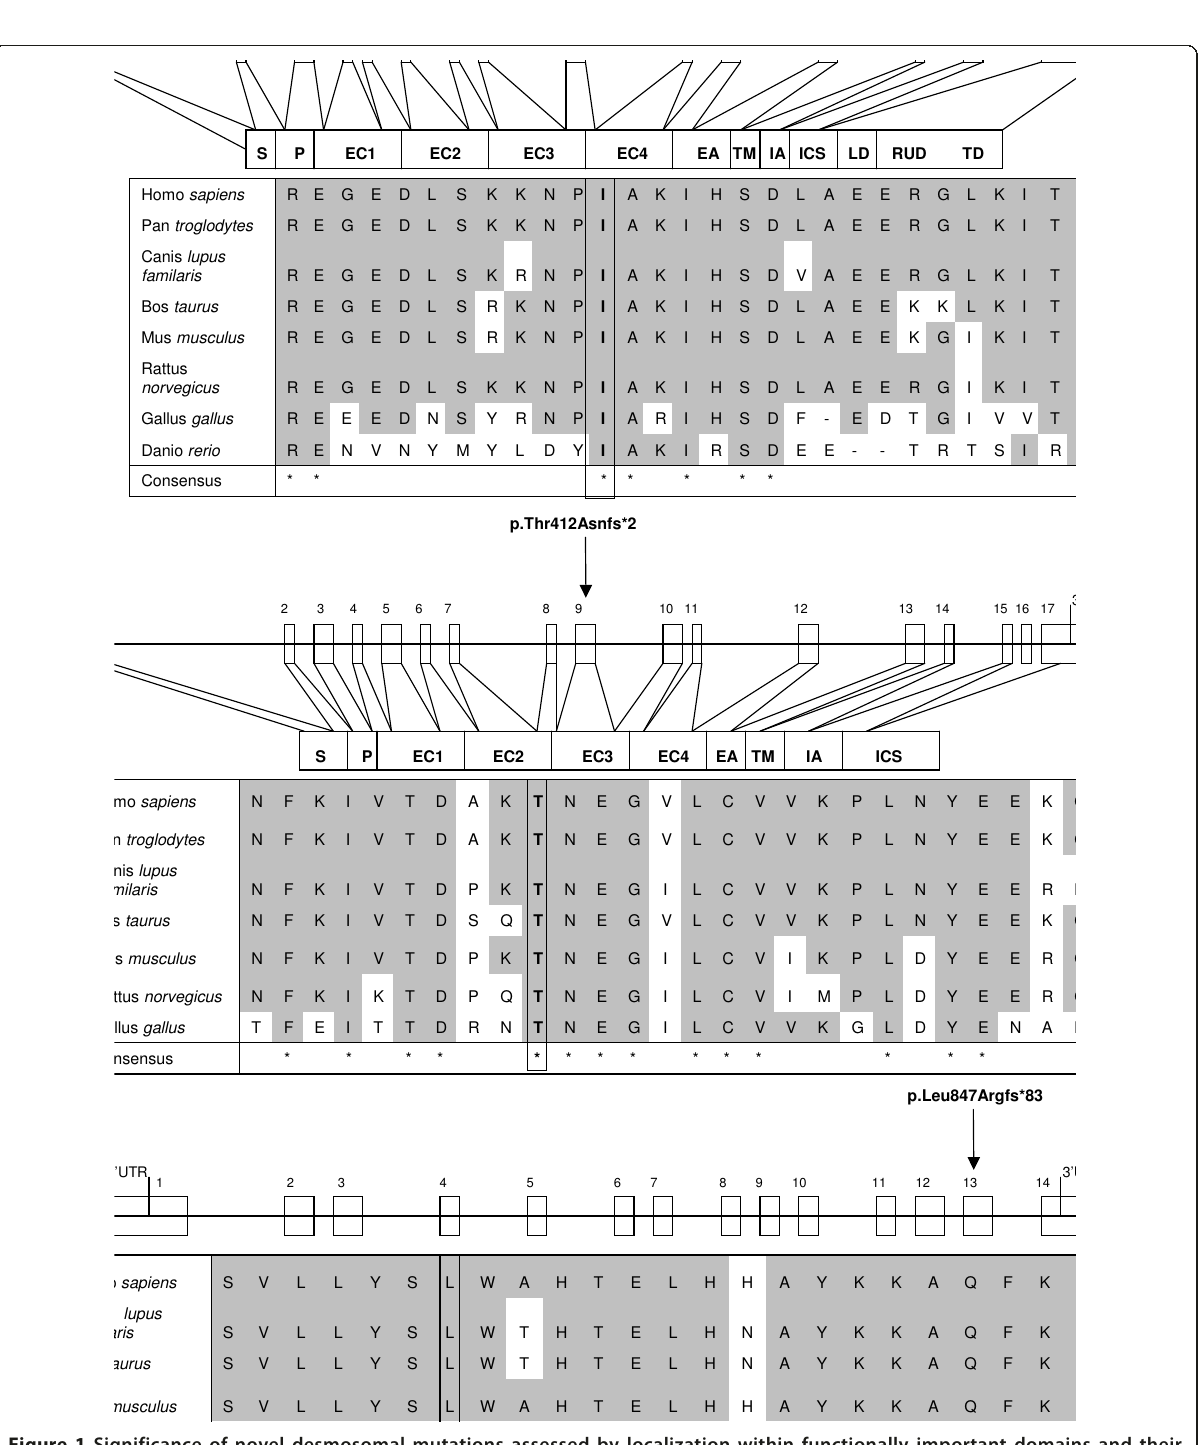
Figure 1 Significance of novel desmosomal mutations assessed by localization within functionally important domains and their evolutionary conservation . (A) DSG2 , p.Ile70Val (c.208A > G); (B) DSC2 , p.Thr412Asnfs*2 (c.1234_1235insA); (C) PKP2 , p.L847Rfs*83 (c.2540delT). The numbered white box signifies an exon; the arrow signifies the site of mutation; the grey background indicates identity across species; the box surrounding an amino acid indicates the mutated residue. S, signal domain; P, preprotein domain; EC, extracellular domain; EA, extracellular anchor; TM, transmembrane domain; IA, intracellular anchor domain; ICS, intracellular cadherin-typical segment domain; LD, linker domain; RUD, repeat unit domain; TD, terminal